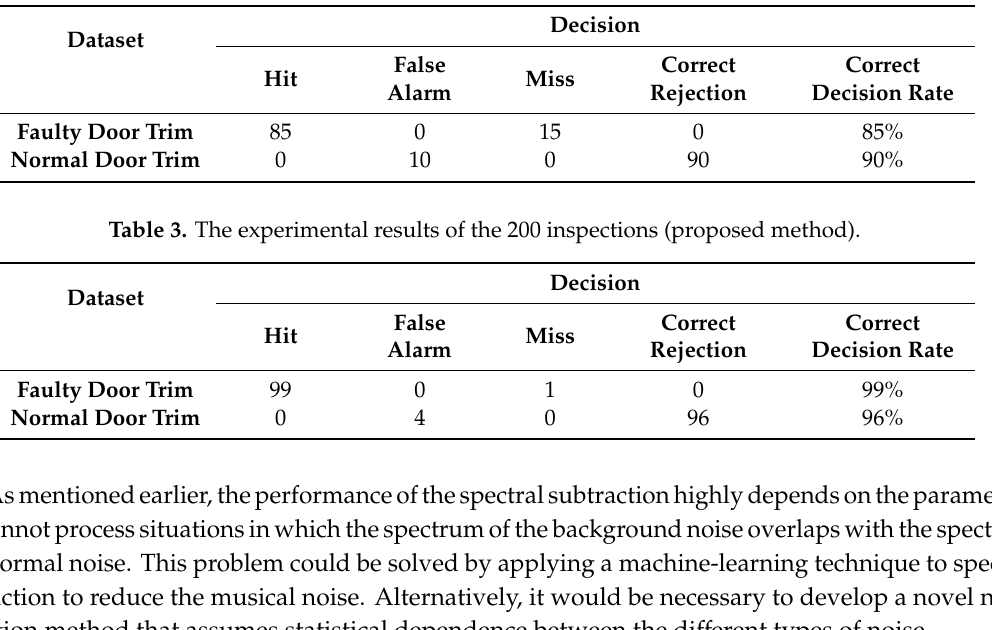
Table 2. The experimental results of the 200 inspections (conventional method).